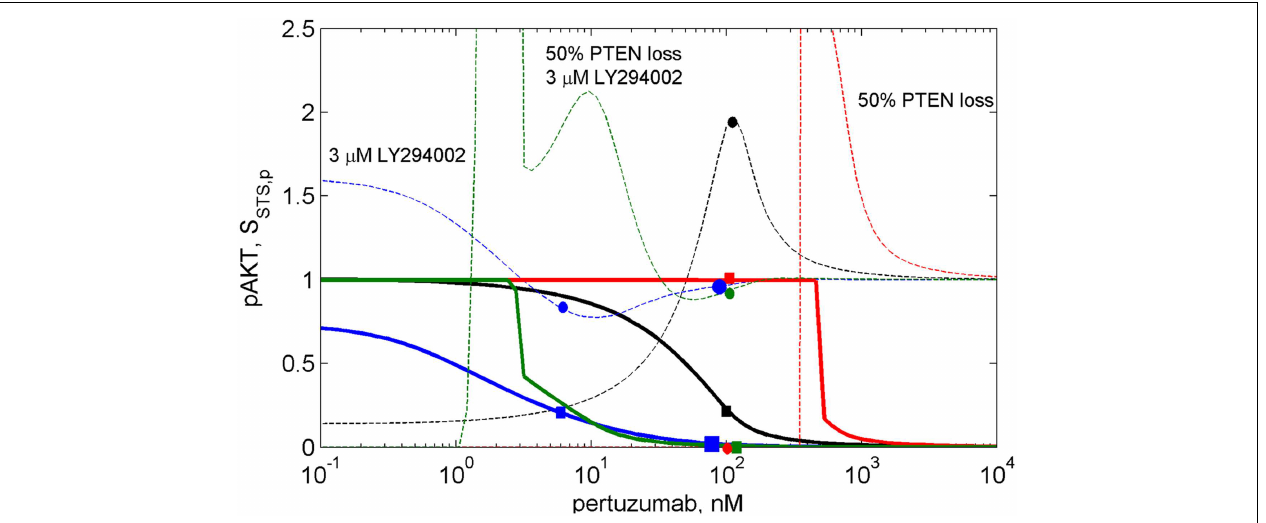
FIGURE 5 |The dose dependences of p AKT inhibition (solid lines) and sensitivity S AKT,k31 (2C4, p ) of the PI3K/PTEN/AKT network to the rate constant of the reaction of PI3K binding with PIP2, k 31 (dash lines) at different drug combinations .The dose dependencies of inhibition and sensitivity on pertuzumab concentration (black lines), at 50% PTEN loss (red lines), at 3 µ M LY294002 (blue lines), at 50% PTEN loss and 3 µ M LY294002 (green